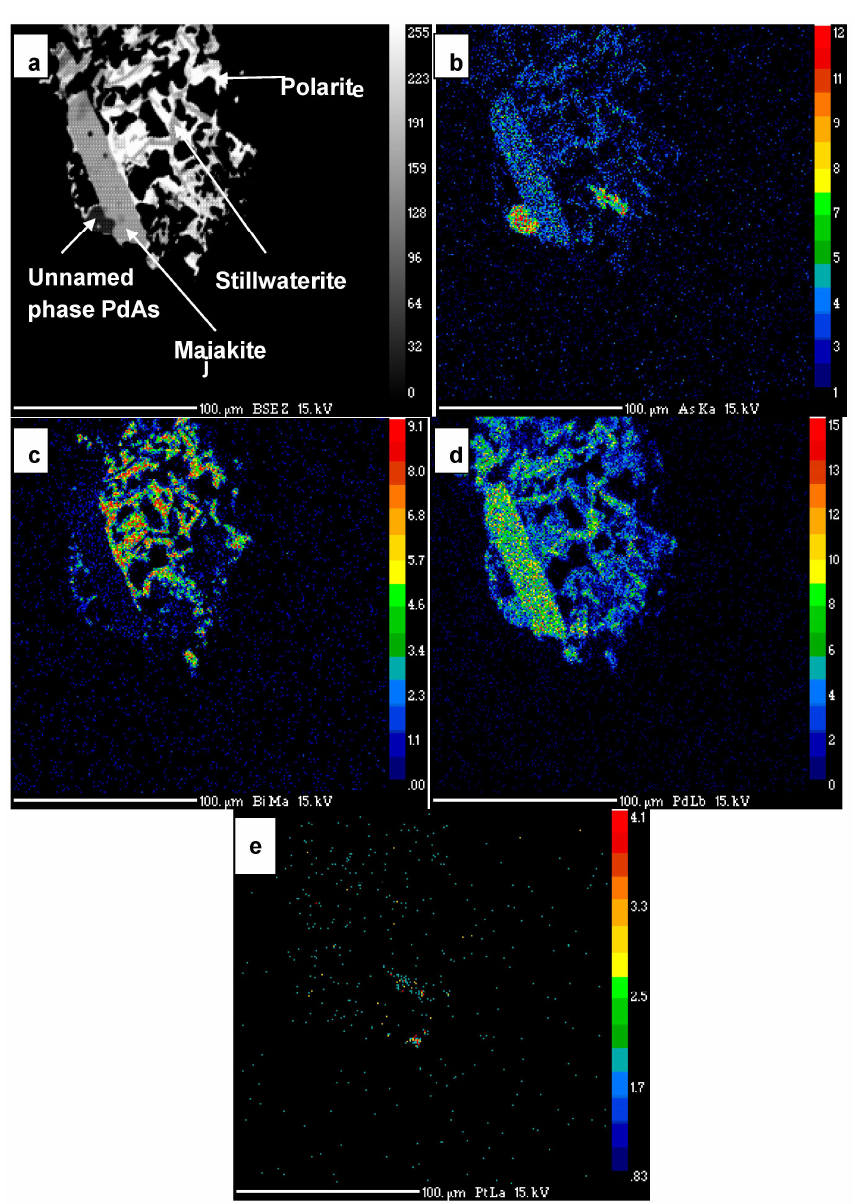
Figure 13. Position of zvyagintsevite, ploarite and sobolevskite from the Southern 2 orebody in the system Pd-PdPb-PdBi.